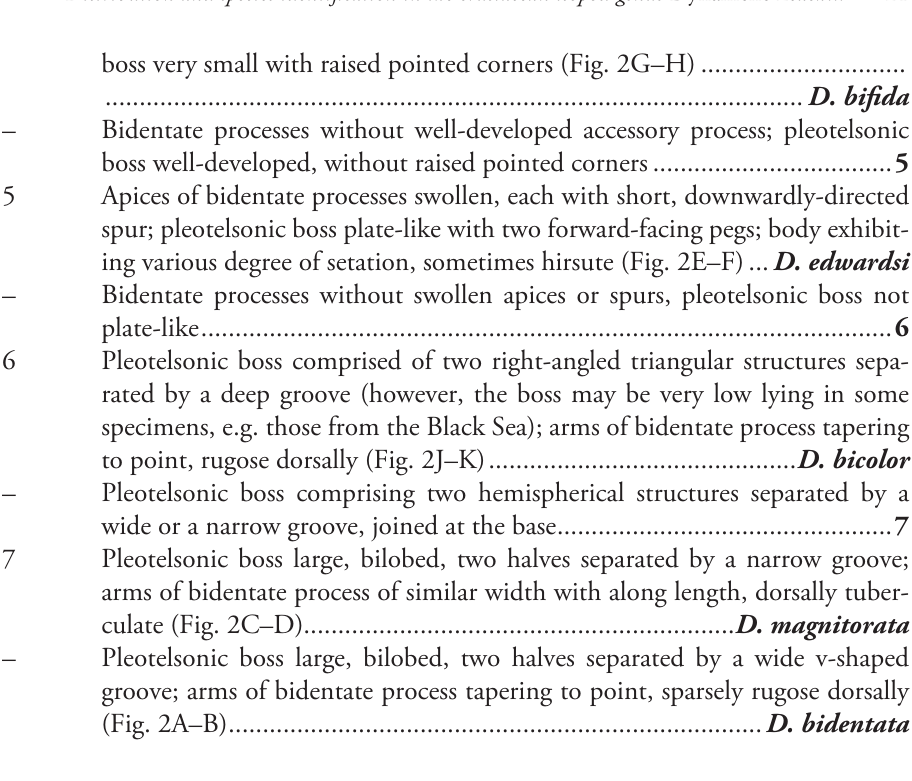
Key to pre-ovigerous females (stage 7) and juveniles of Dynamene spp. along the NE Atlantic-Black Sea axis 1 Sphaeromatid without process arising from the posterior margin of the pere- onite 6, and with simple pleotelsonic foramen; with or without dorsal tuber- culation ........ juvenile and ♀♀ Campecopea , Dynamene and Ischyromene – Without tuberculation on surface of posterior pereonites, pleonites and/or pleotelsonic dome (Figs 1A, B; Figs 4-upper row 6-8, 3A–M) ...................... ..................................................................... juvenile and ♀♀ Dynamene ... 2 2 Body flattened, epimera flattened to form a shelf round the body; pleotel- sonic foramen at end of a well-developed tube (Fig. 3J-K) ...... D. tubicauda – Body convex, pleura not flattened to form shelf round body; pleotelsonic foramen either flush with edge of pleotelson or at end of a short tube ......... 3 3 Pleotelsonic dome smoothly rounded in side view, pleotelsonic foramen open and flush with edge of pleotelson or at end of short tube ............................ 4 – Pleotelsonic dome keeled in side view, with or without a median protuber- ance ............................................................................................................ 5 4 Pleotelsonic foramen open and flush with edge of pleotelson (Fig. 3A–B) .... ................................................................................................ D. bidentata – Pleotelsonic foramen at end of short tube (Fig. 3L–M) .................. D.